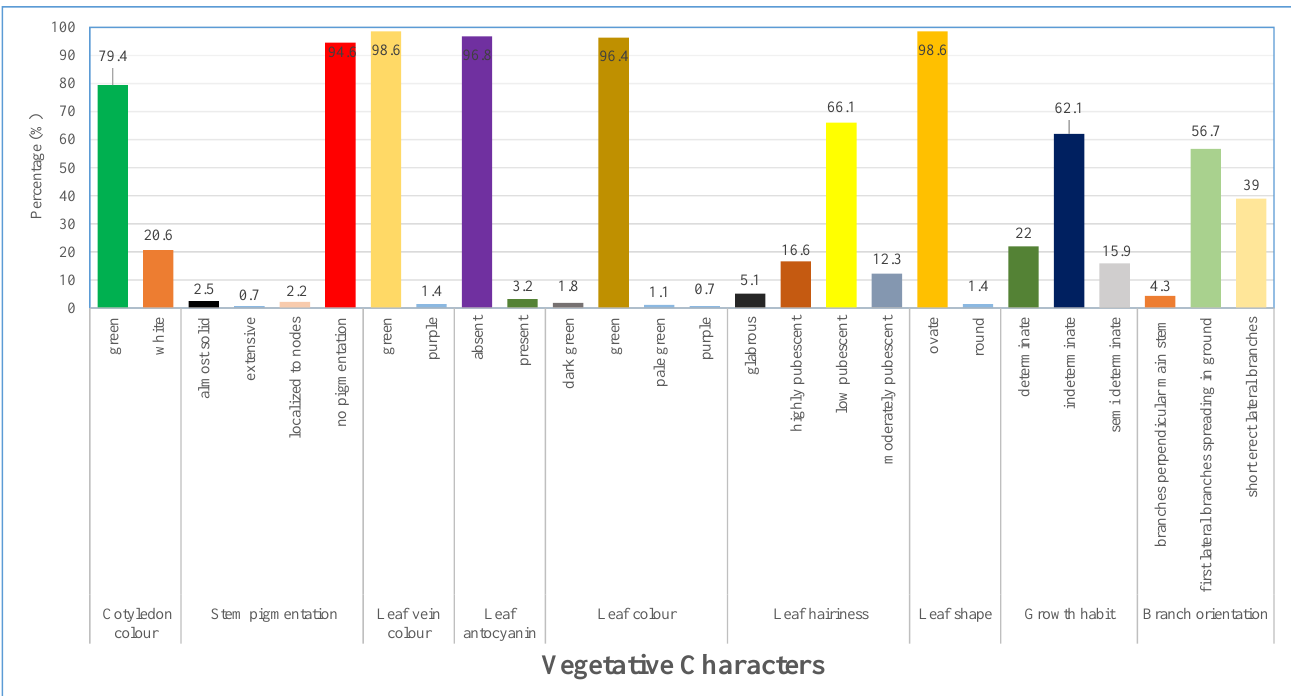
Figure 1. Variations in selected vegetative characters of lablab accessions.